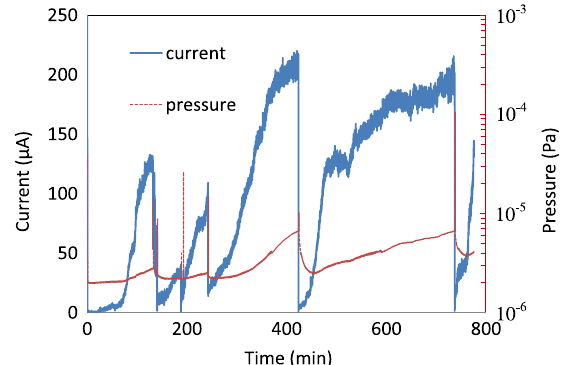
FIG. 8. Long-term experiment with multiple breakdowns followed by slow current increases. Each breakdown exhibits an immediate drop in current and a pressure